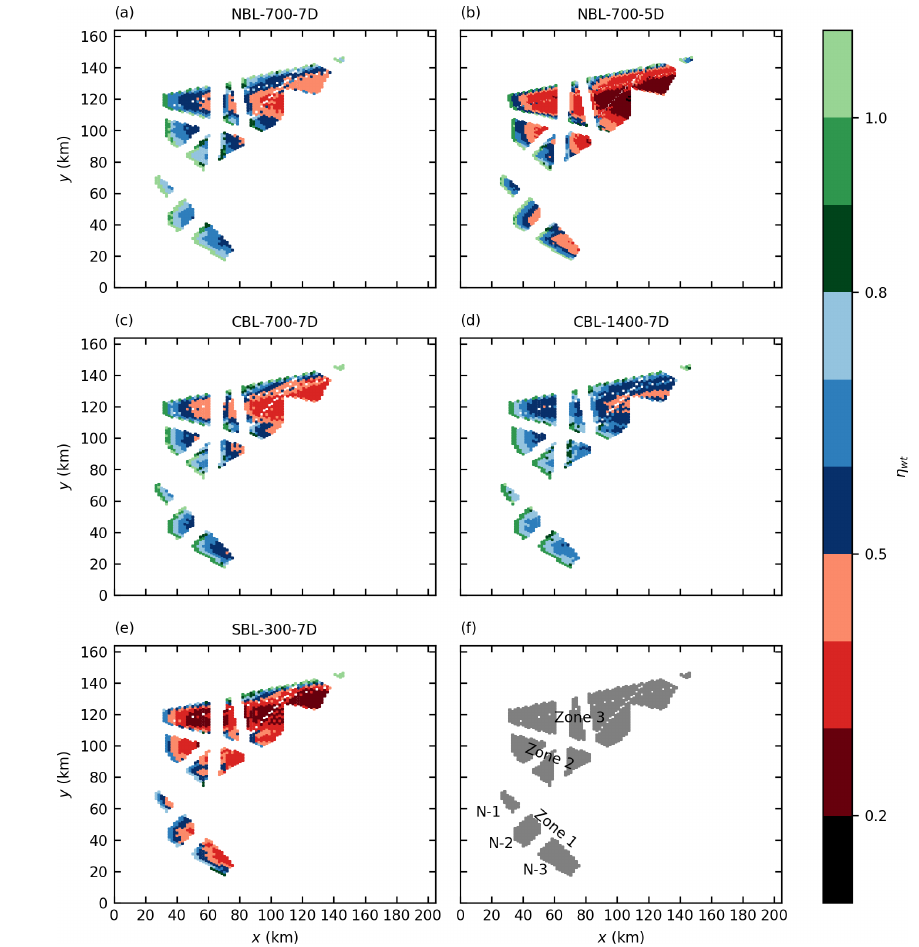
Figure 10. Wind turbine efficiencies η wt for all five cases (a–e) and overview of wind farm names (f)